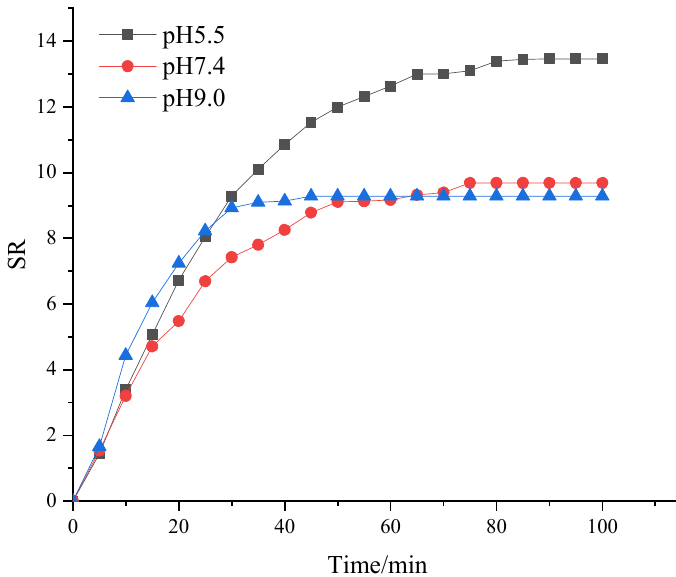
Figure 9. pH responsive properties of gel swelling equilibrium at pH 5.5, pH 7.4, and pH 9.0.